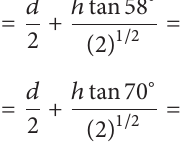
One pass of the field scan was done for each plot in the wheat fields. For each measurement, the field scan recorded spectral information at all wavebands from 600 to 1100 nm with 10 nm intervals. N-sensor scans were done at